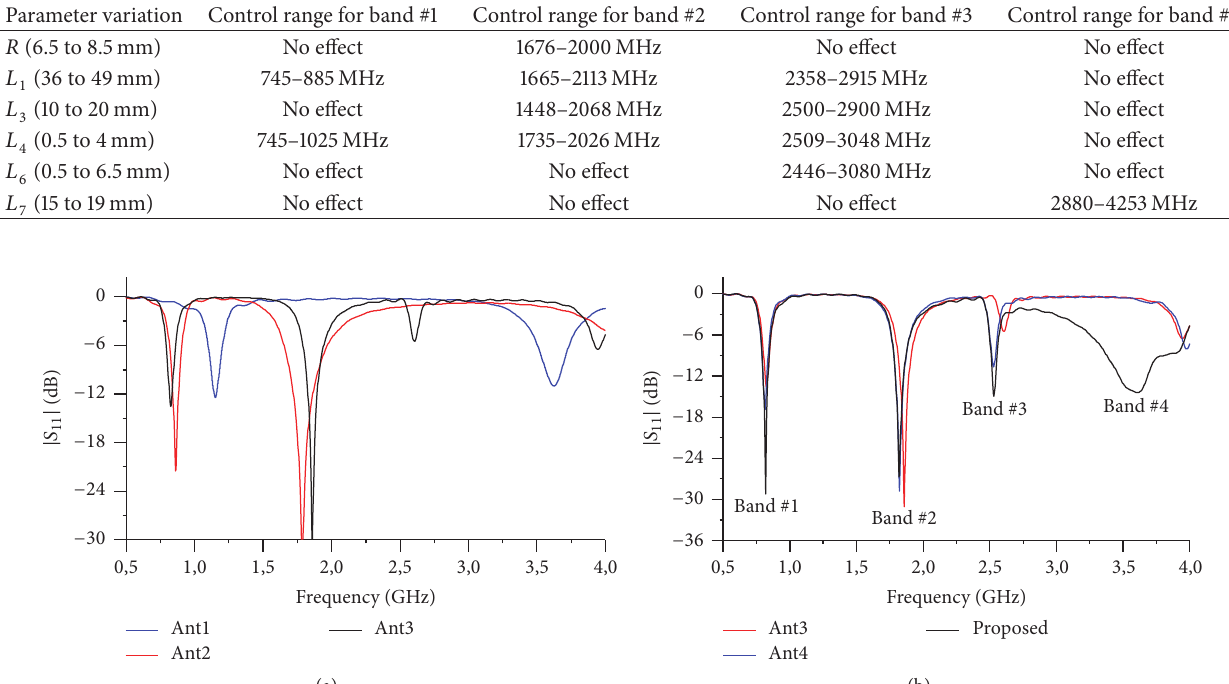
Figure 3: Comparison of simulated reflection coefficient for different antennas: (a) Ant1, Ant2, and Ant3 and (b) Ant3 and Ant4 and the proposed